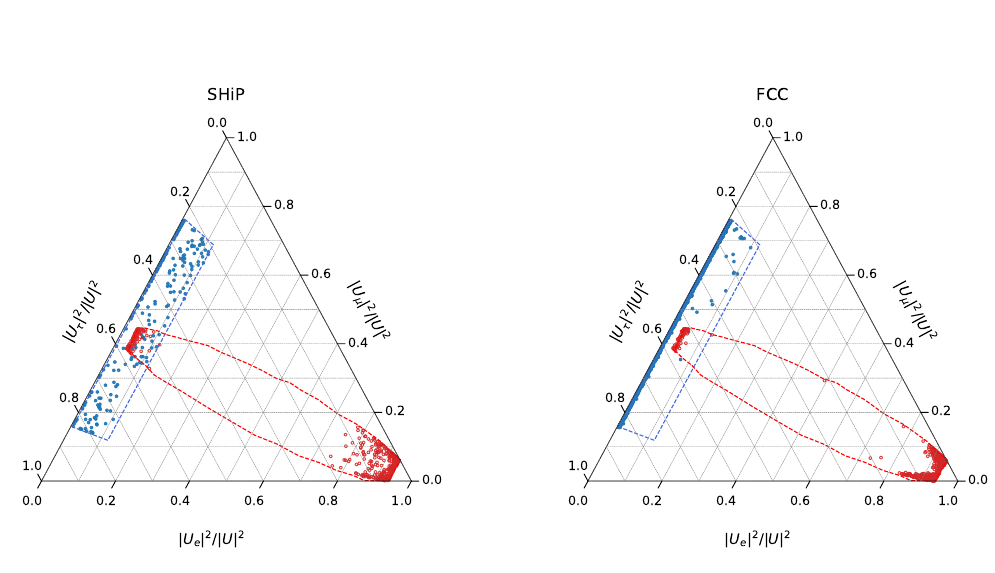
Figure 14 . Points fo the numerical scan with successful baryogenesis within the SHiP (left) and FCC (right) regions for fixed ∆ M/M = 10 − 2 and NH (blue) or IH (red). The dashed lines correspond to the regions of figure 13.